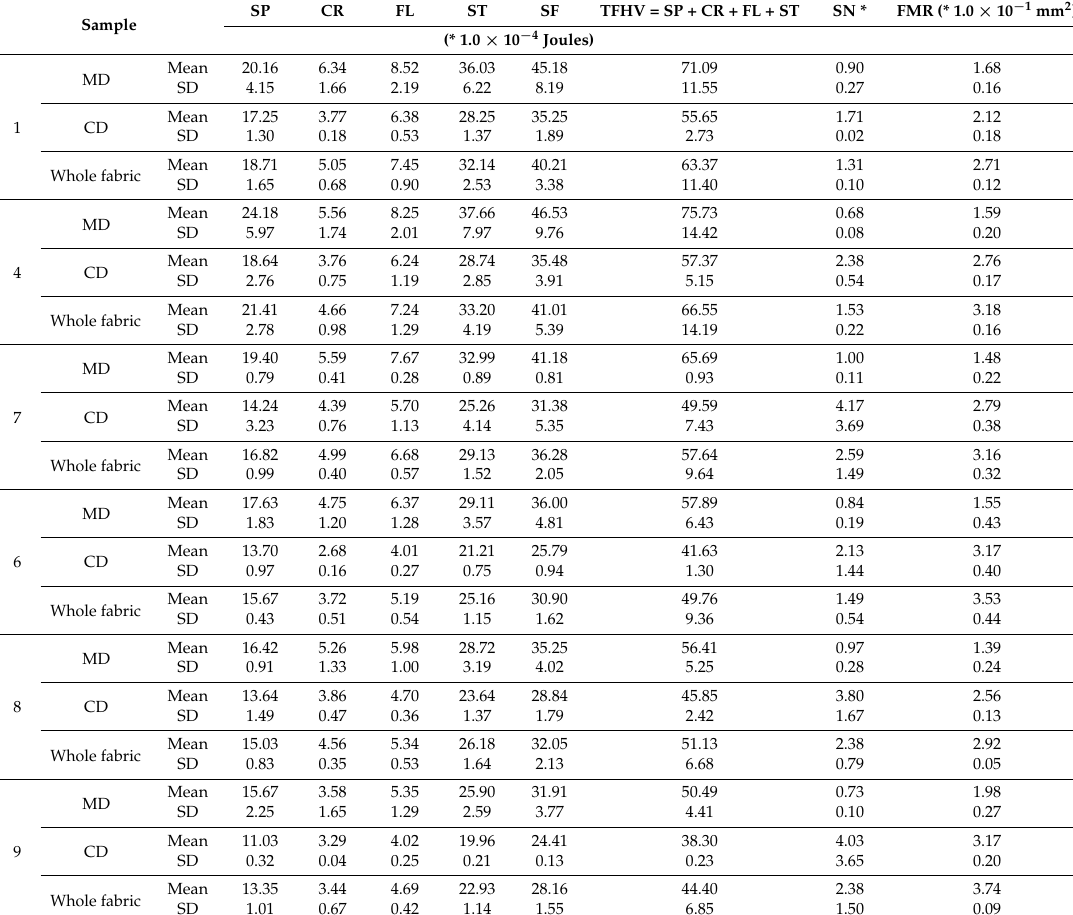
Table 3. Details of the Resultant Tactile Descriptor